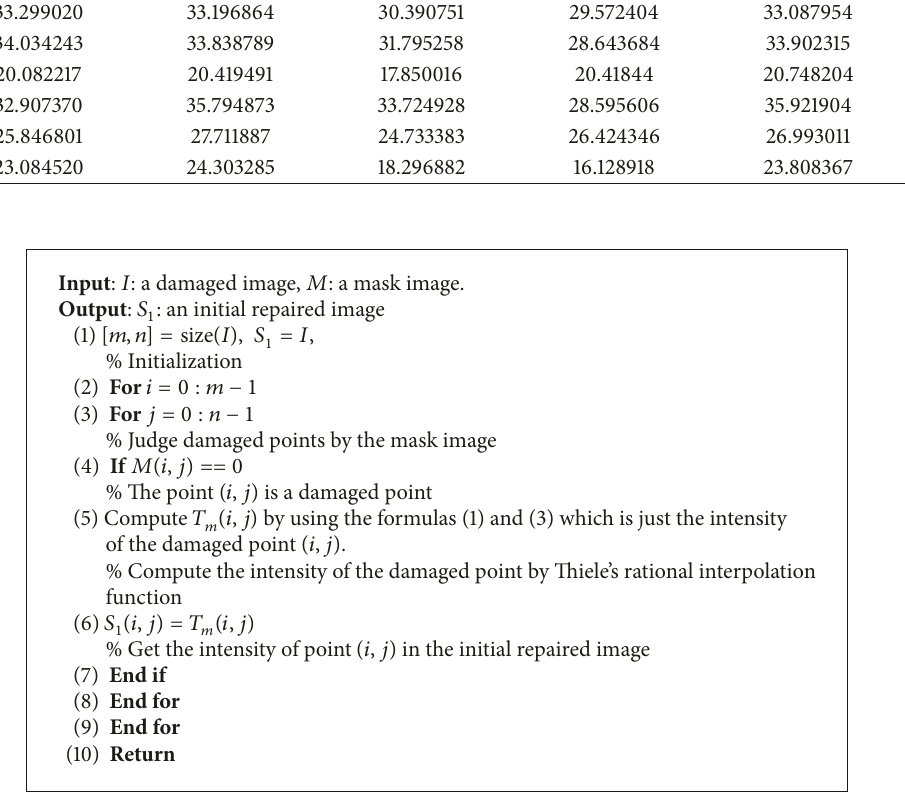
Algorithm 1: Adaptive inpainting via Thiele’s rational interpolation.